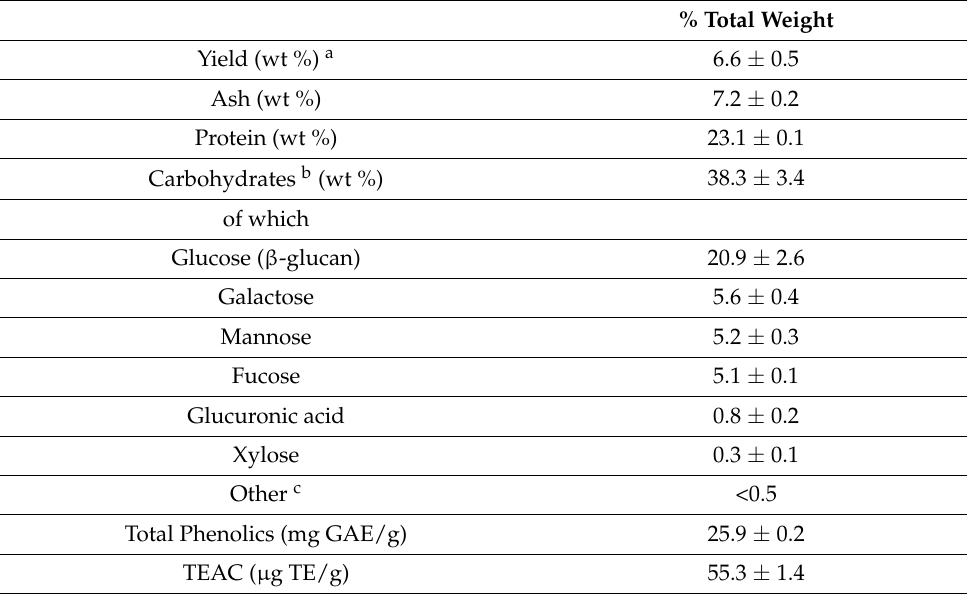
Table 1. Characterization of the GE extract composition. Mean value ± standard